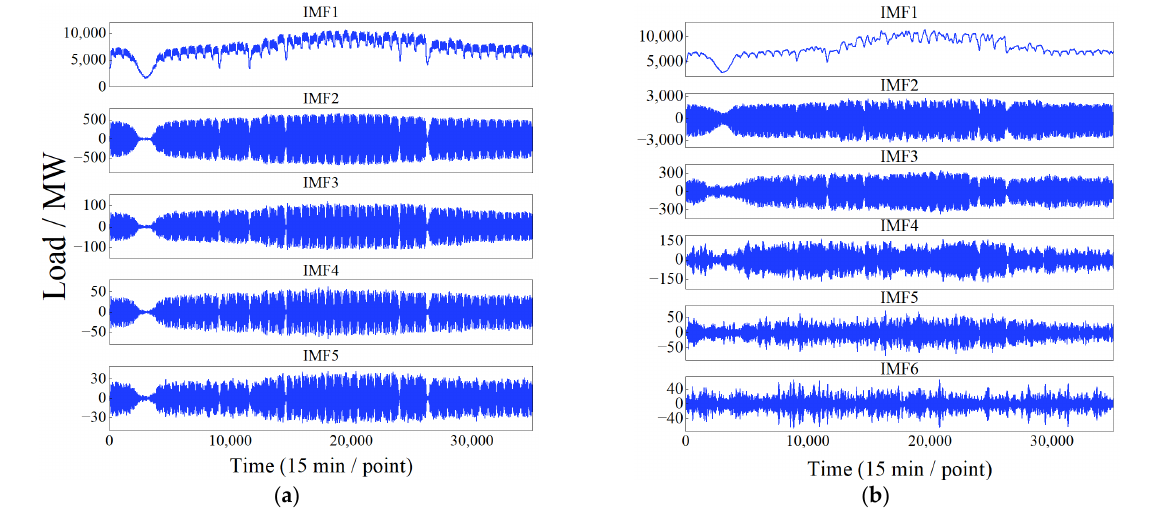
Figure 4. Decomposition results of VMD: ( a ) Dataset A; ( b ) Dataset B.